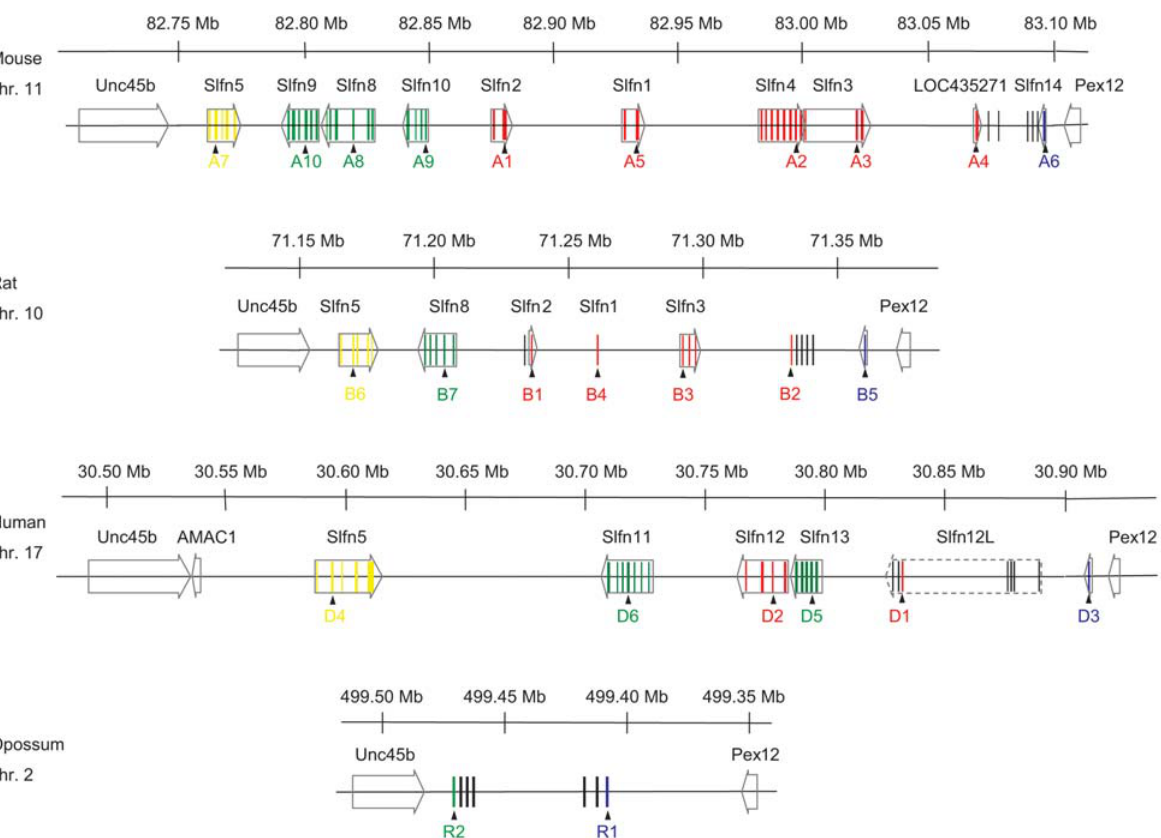
Figure 2 Orthologous regions in mouse, rat, human and opossum that contain the Slfn cluster. Indicated are the Ensembl annotated Slfn genes and the Slfn -related sequences identified by Bustos et al. (3), their exons, and direction of transcription. The code and location of the sequences used in the phylogenetic analysis represented in Figure 3 is indicated below. Colors indicate their relationships according to the phylogenetic major clades (red s Group 1; yellow s Group 2; blue s Group 3; green s Group 4; black s unidentified). Opossum R2 sequence (which could not be included in Figure 3 phylogenetic analysis), was found to be more similar to Slfn8, 9 and 10 (Group 4) sequences than to any other mouse sequences (3). Adapted from (3) with